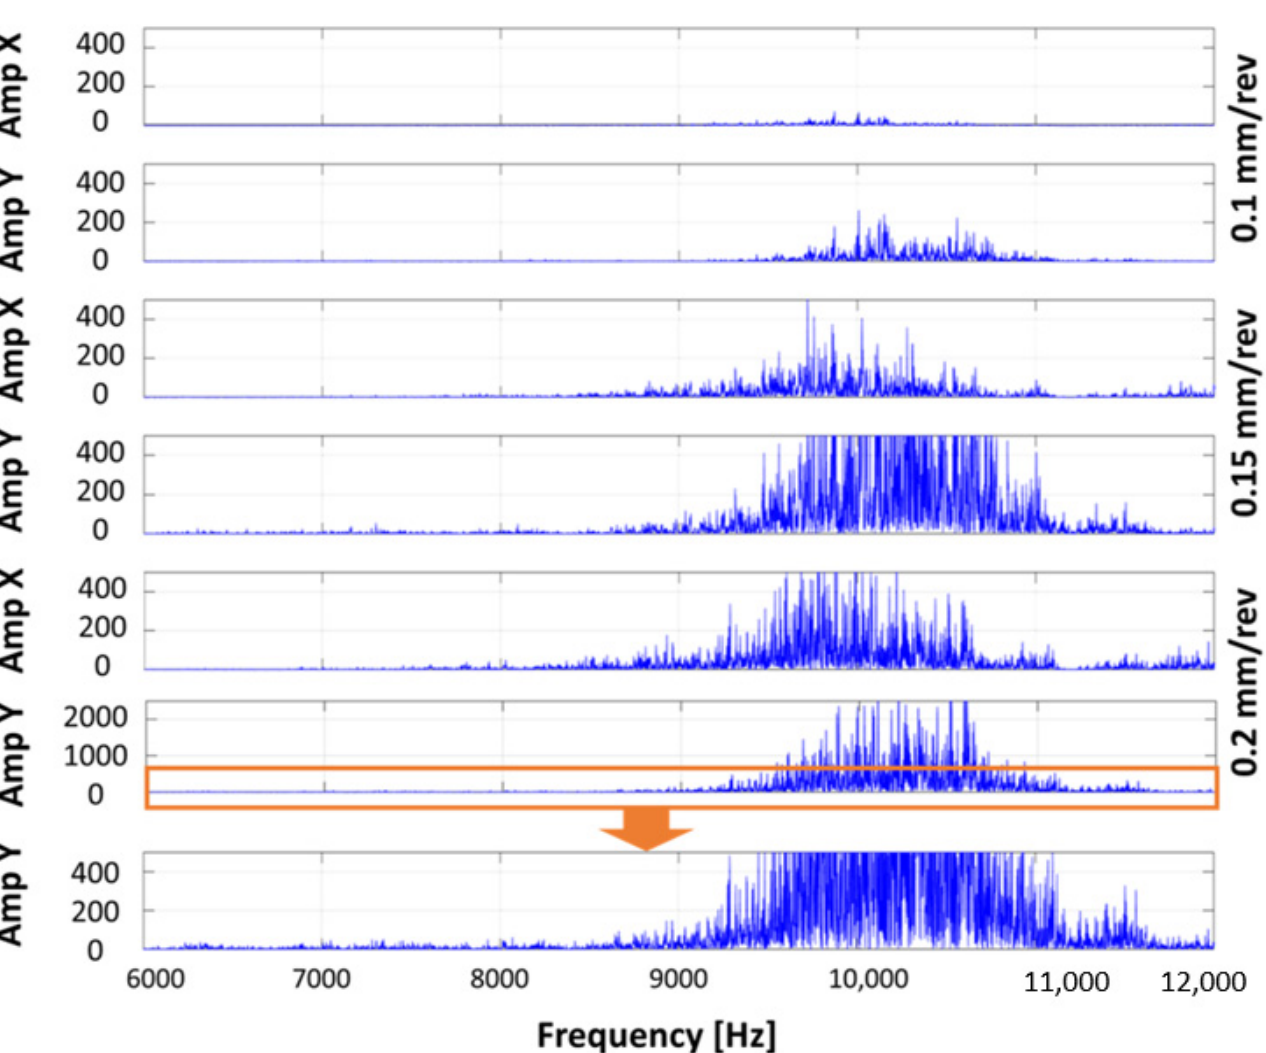
Figure 8. The FFT plots of the frequency domain in the x and y coordinate for the bottom side of the ZnO ceramic under different feed velocities.